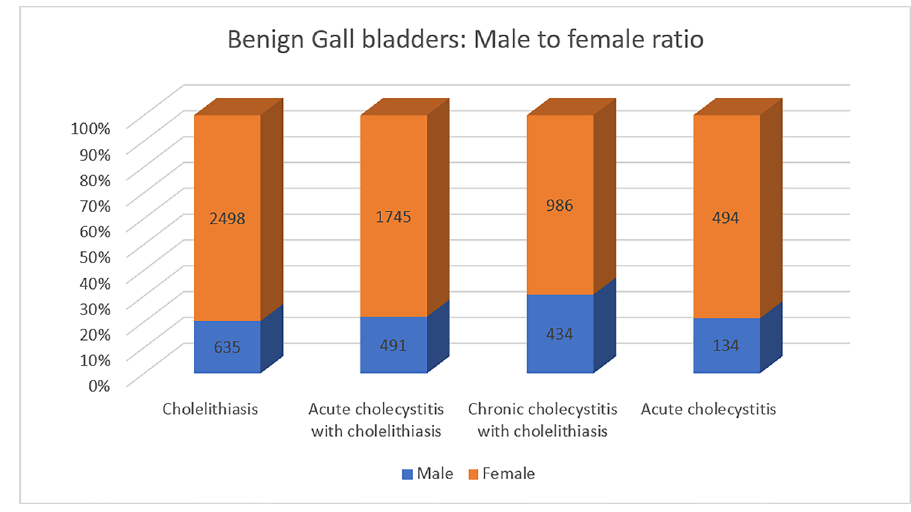
Figure 5. Male to female ratio for benign gall bladder